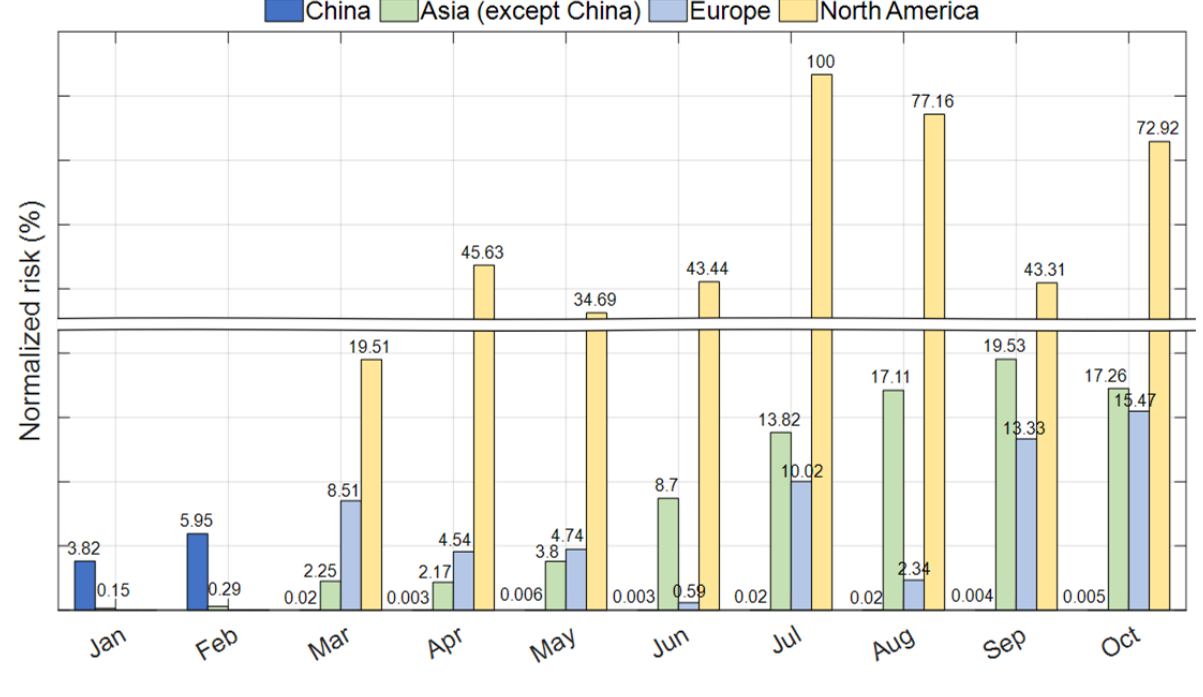
Figure 3. The country-specific risk of case importation from the top 13 countries to South Korea from January to October 2020.